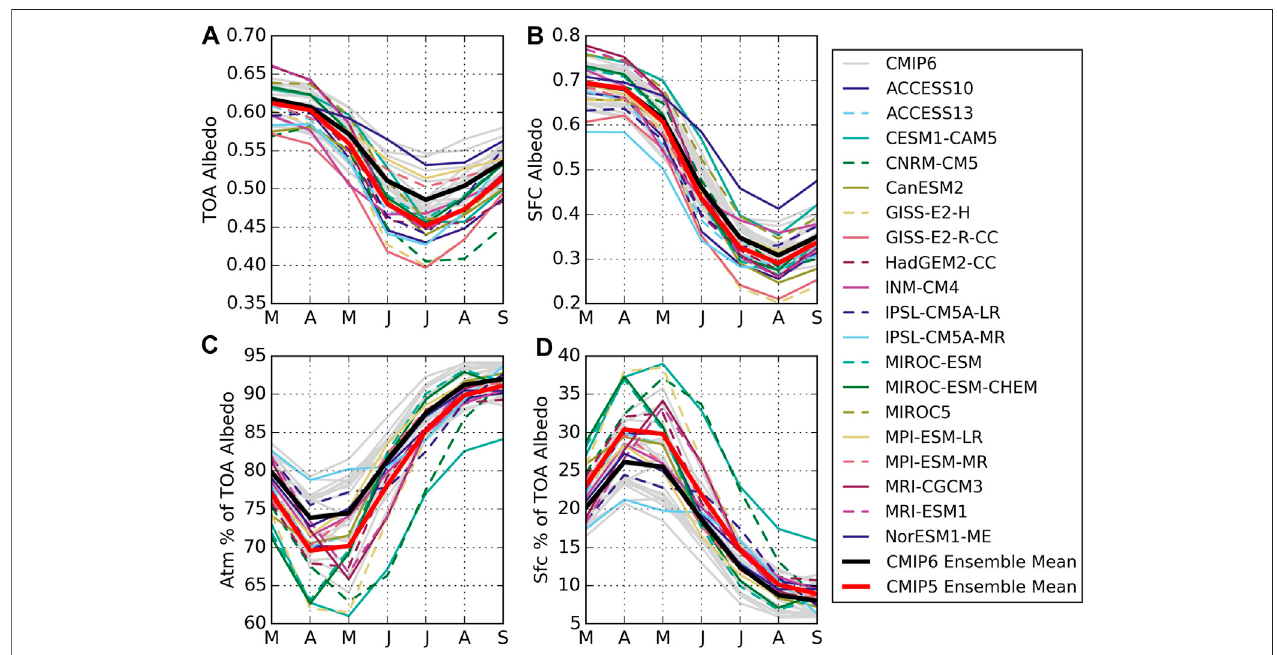
FIGURE7| AnnualcyclesofTOAandsurface(SFC)albedos (A , B) andpercentcontributionsoftheatmosphere (C) andsurface (D) totheTOAalbedofromCMIP5 (color lines) and CMIP6 (grey). Averages are calculated over 1986 – 2005. Ensemble means are shown in black for CMIP6 and red for CMIP5.